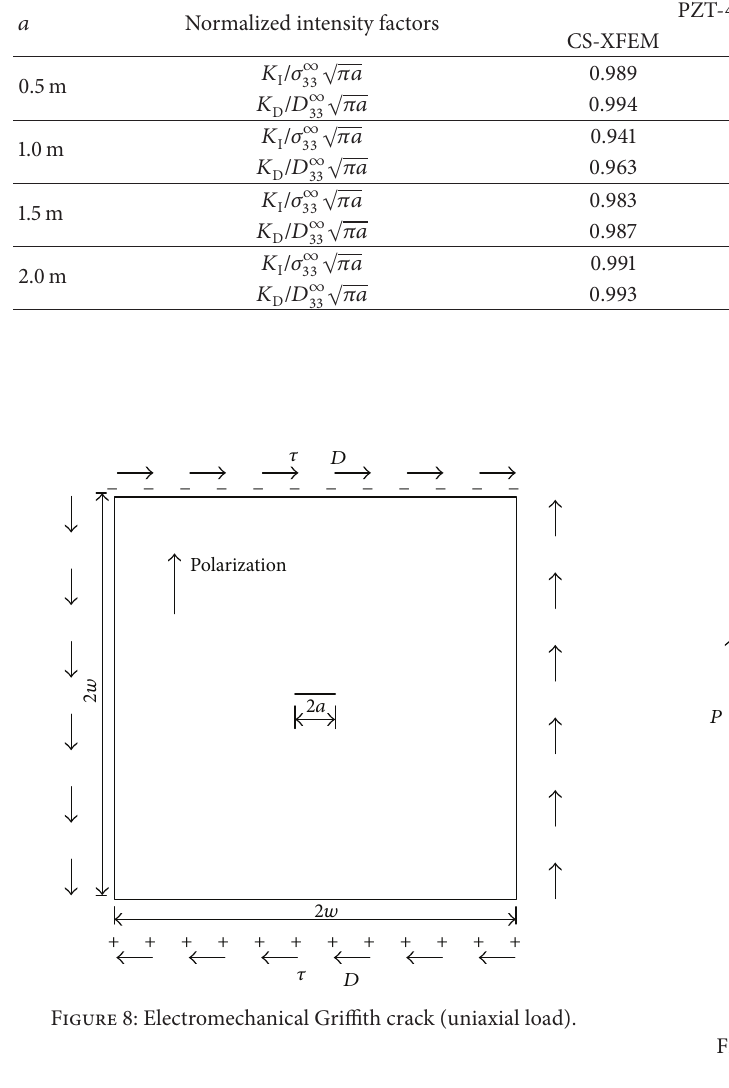
Table 3: Normalized intensity factors under different crack lengths for electromechanical Griffith crack (uniaxial load). 𝑎 Normalized intensity factors